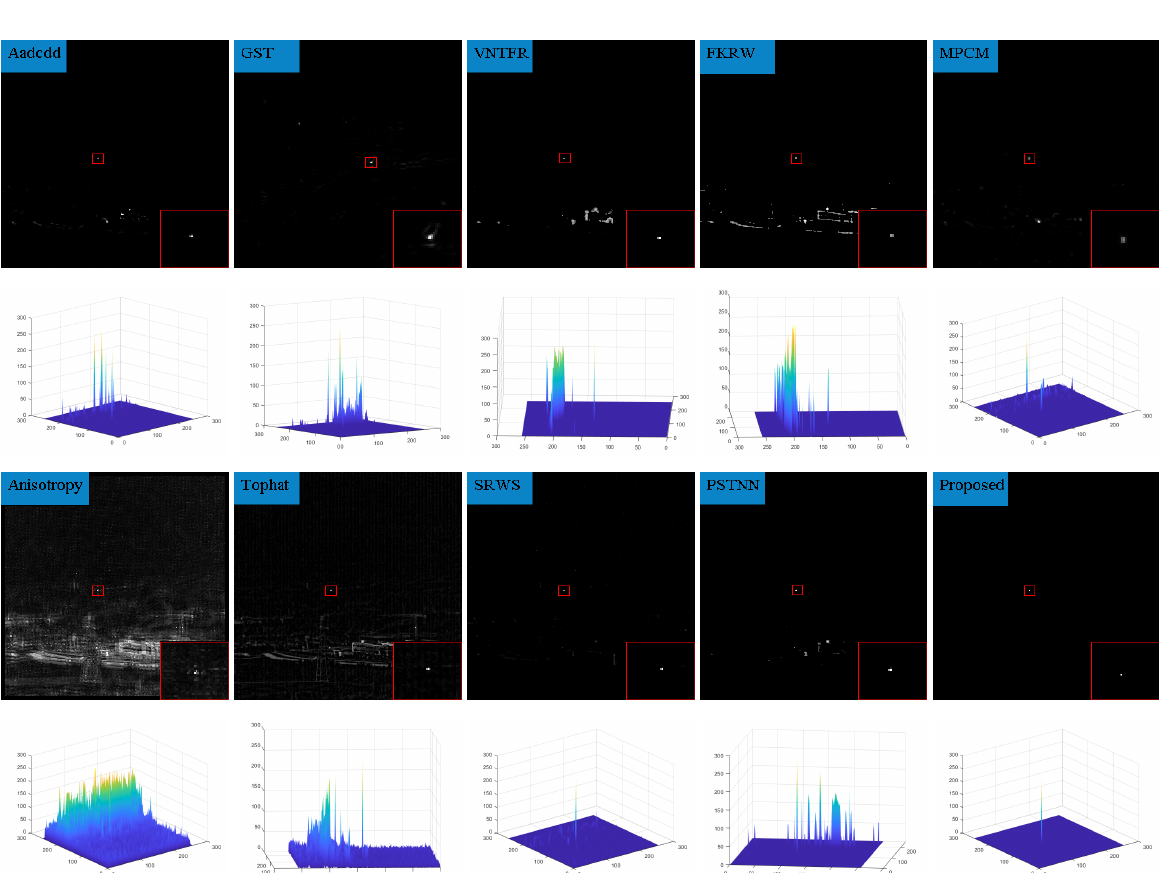
Figure 10. Detection results of sequence 2.